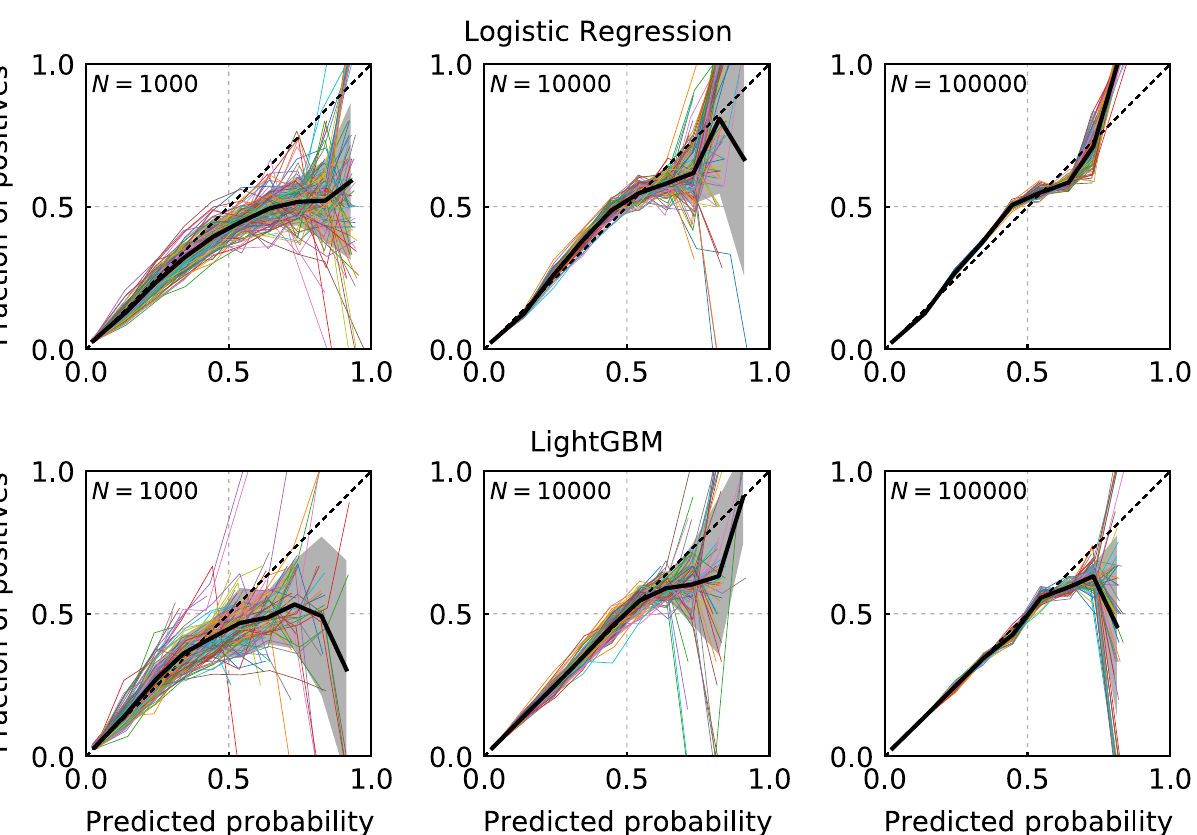
Figure 4. Reliability diagrams for the LR (upper figures) and LightGBM (lower figures) methods with various sample sizes. The samples of N = 1000 , N = 10,000 , and N = 100,000 are shown in the left, middle, and right figures, respectively. There are 100 reliability curves in each